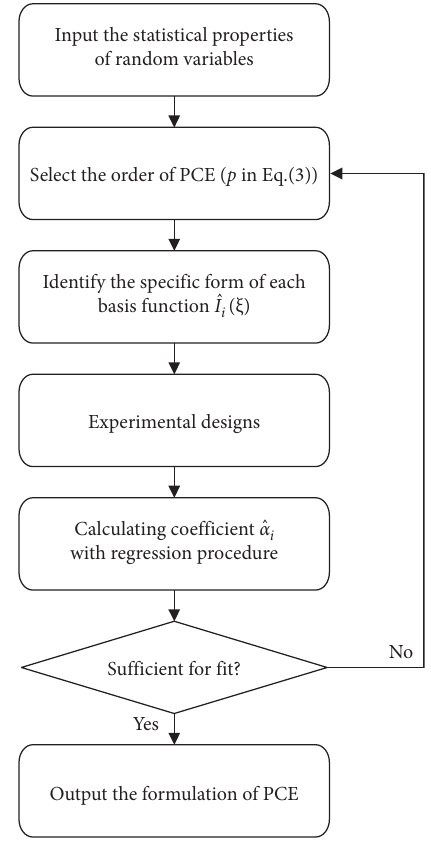
Figure 3: The process of establishing PCE with SRSM.